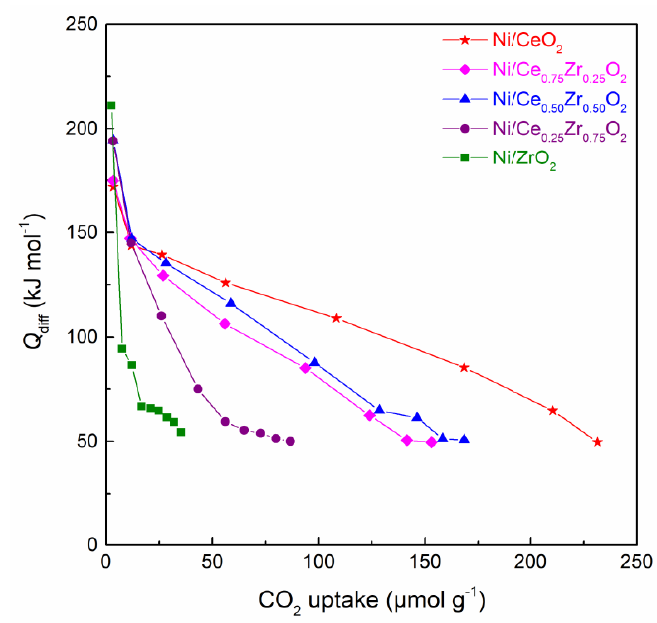
Figure 5. Differential heat of adsorption, Q diff , as a function of CO 2 uptake on the Ni / Ce x Zr 1 − x O 2 samples.